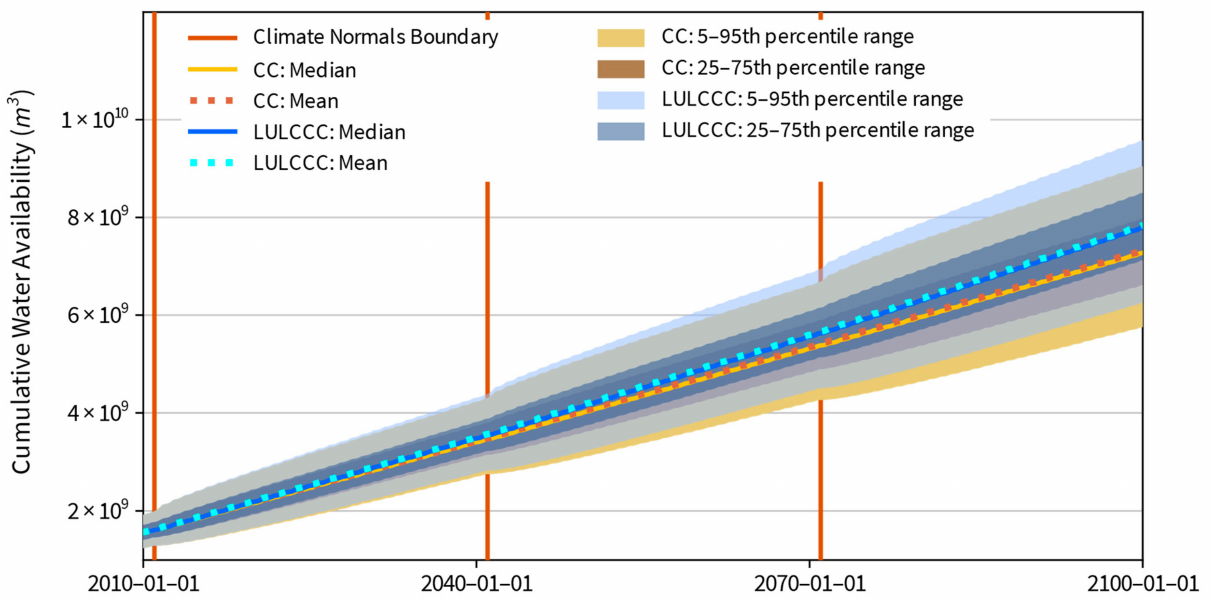
Figure 9. Comparison of cumulative water availability between scenarios. Cumulative water availability is presented in cubic meters (m 3 ). Millimeters (mm) of depth across the 471 km 2 watershed area can be converted to m 3 by multiplying depth in millimeters by area in km 2 by 1000 m 3 /km 2 · mm. One mm of water depth across the watershed corresponds to 4.71 × 10 5 m 3